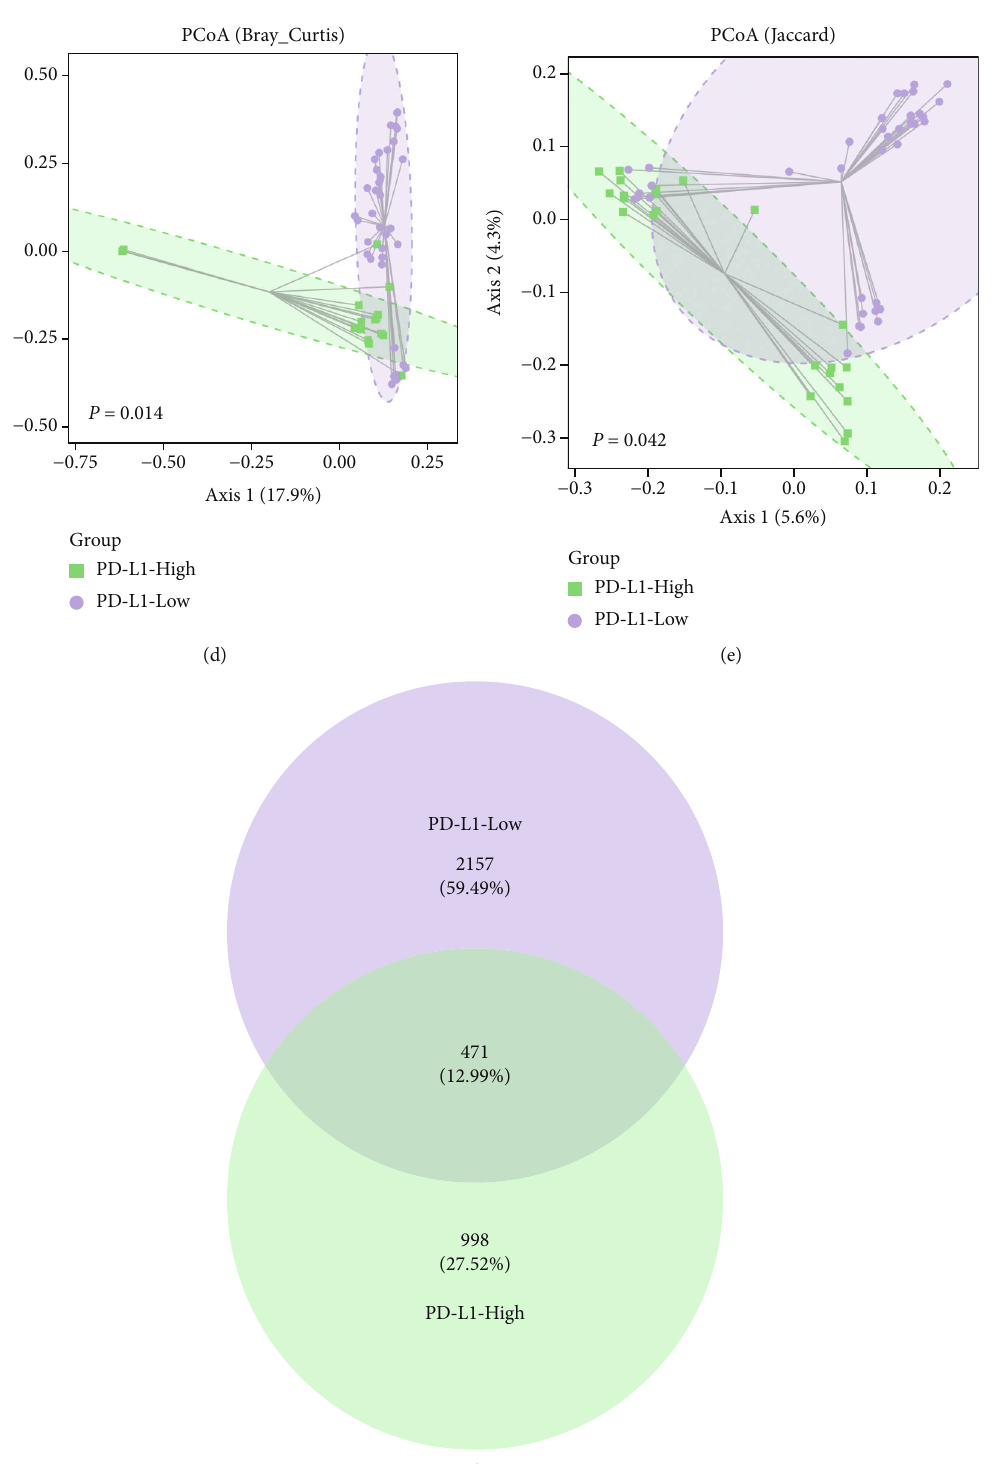
Figure 1: A taxonomic di ff erence of fungi in the di ff erent PD-L1 expression groups. (a) H-E and IHC staining for PD-L1 expression. (b and c) The alpha-rarefaction curves and rank abundance curves. (d and e) Based on the Bray-Curtis and Jaccard distance, PCoA in two groups (ANOSIM and Adonis test). (f) The Venn